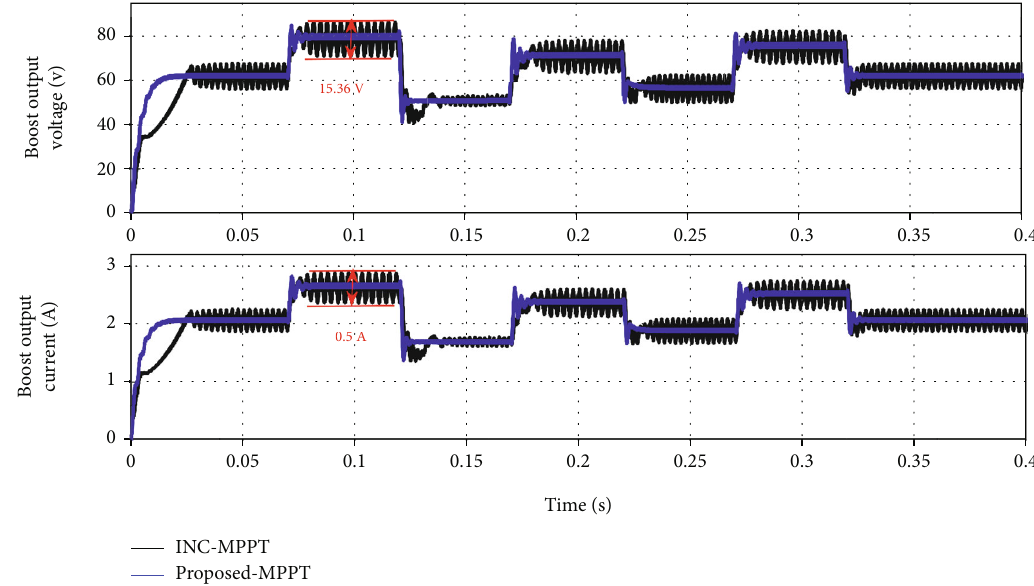
Figure 13: Comparison of the simulation results of the output voltage and current of the boost